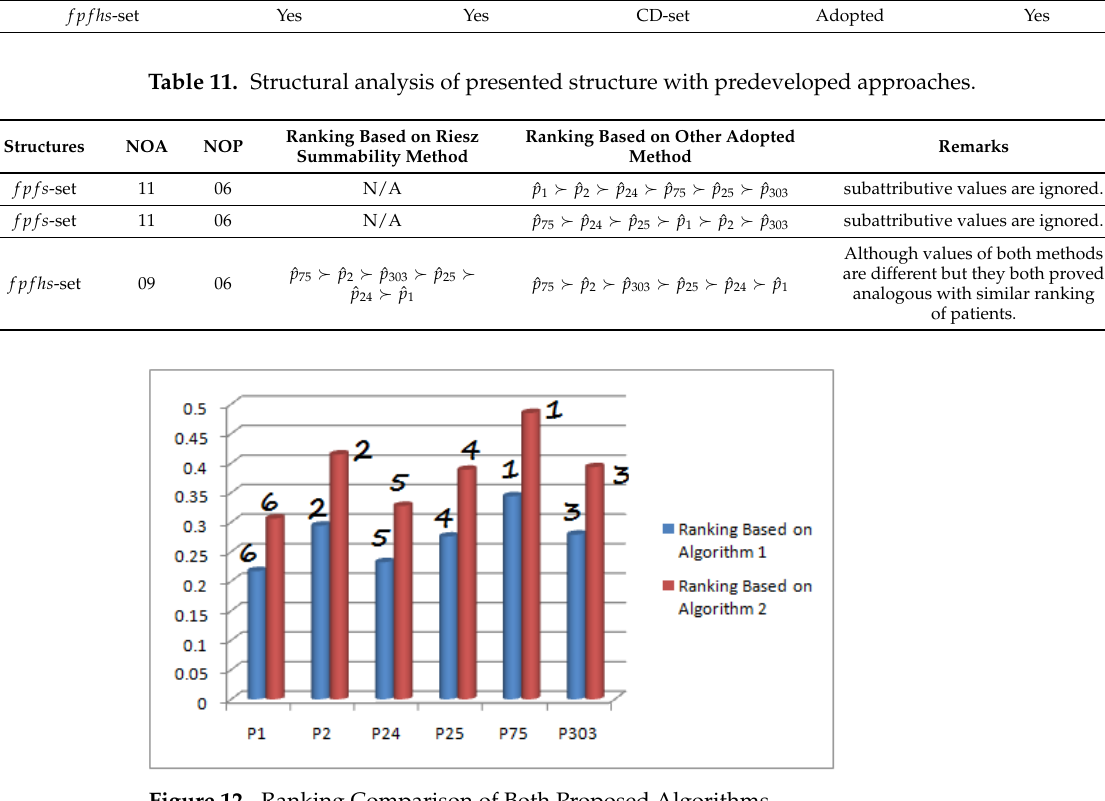
Figure 12. Ranking Comparison of Both Proposed